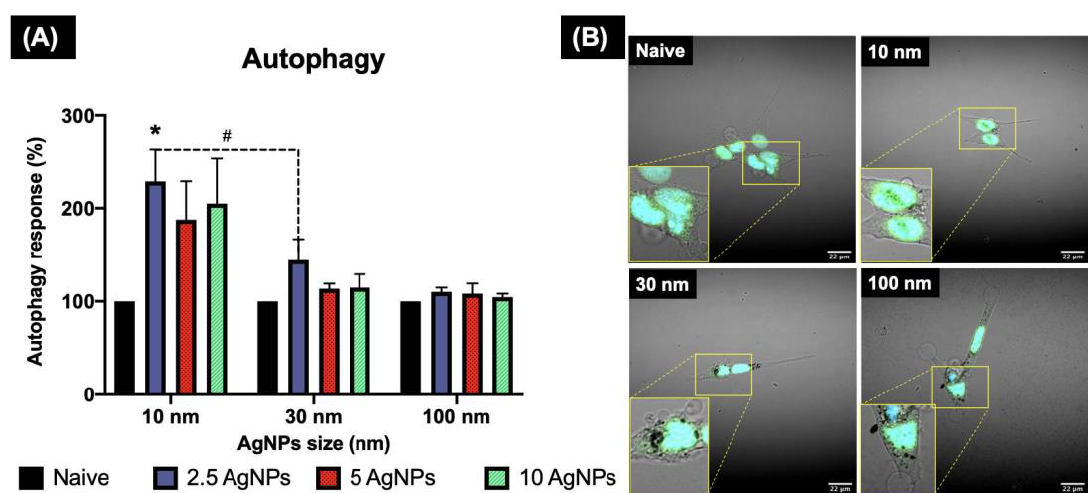
Figure 7. Autophagy induction in ZF4 cells exposed to AgNPs as determined by confocal microscopy. ZF4 Cells were treated with 2.5, 5, and 10 µ g/mL AgNPs of three different sized AgNPs (10, 30, and 100 nm) for 24 h. Images of the cells with the nucleus (blue) and autophagosome staining (green) were taken at 60 × with a NIKON A1R 808 series microscope (Nikon, Tokyo, Japan). A close-up of the labelled cells is marked with yellow lines. The intensity of the labelled autophagosomes in ZF4 cells was recorded by FIJI. ( A ) Results of three individual replicates are expressed as mean and standard deviation (Mean ± SD). A statistical comparison between all the treatments was performed. Data with asterisks (*) indicate a statistical difference (* p < 0.05) between the treatments compared to the untreated control (naive). The symbol above the bars (#) represents a statistically significant difference ( # p < 0.05) between the marked treatments. ( B ) Cells treated with 10 µ g/mL of different AgNPs sizes and the control. Images for the remaining AgNP concentrations and sizes can be found in the Supplementary Materials (Figure